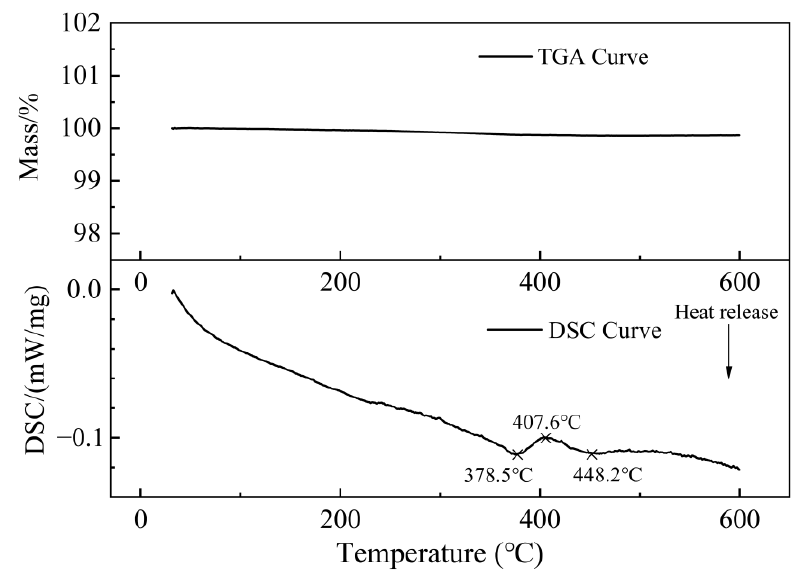
Figure 7. TGA/DSC curves of C17200 beryllium copper alloy.